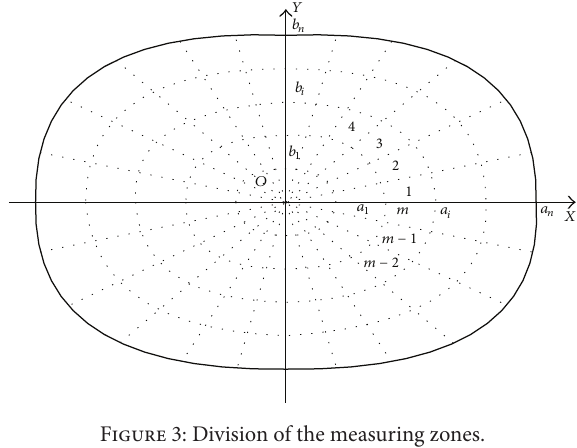
Figure 3: Division of the measuring zones.